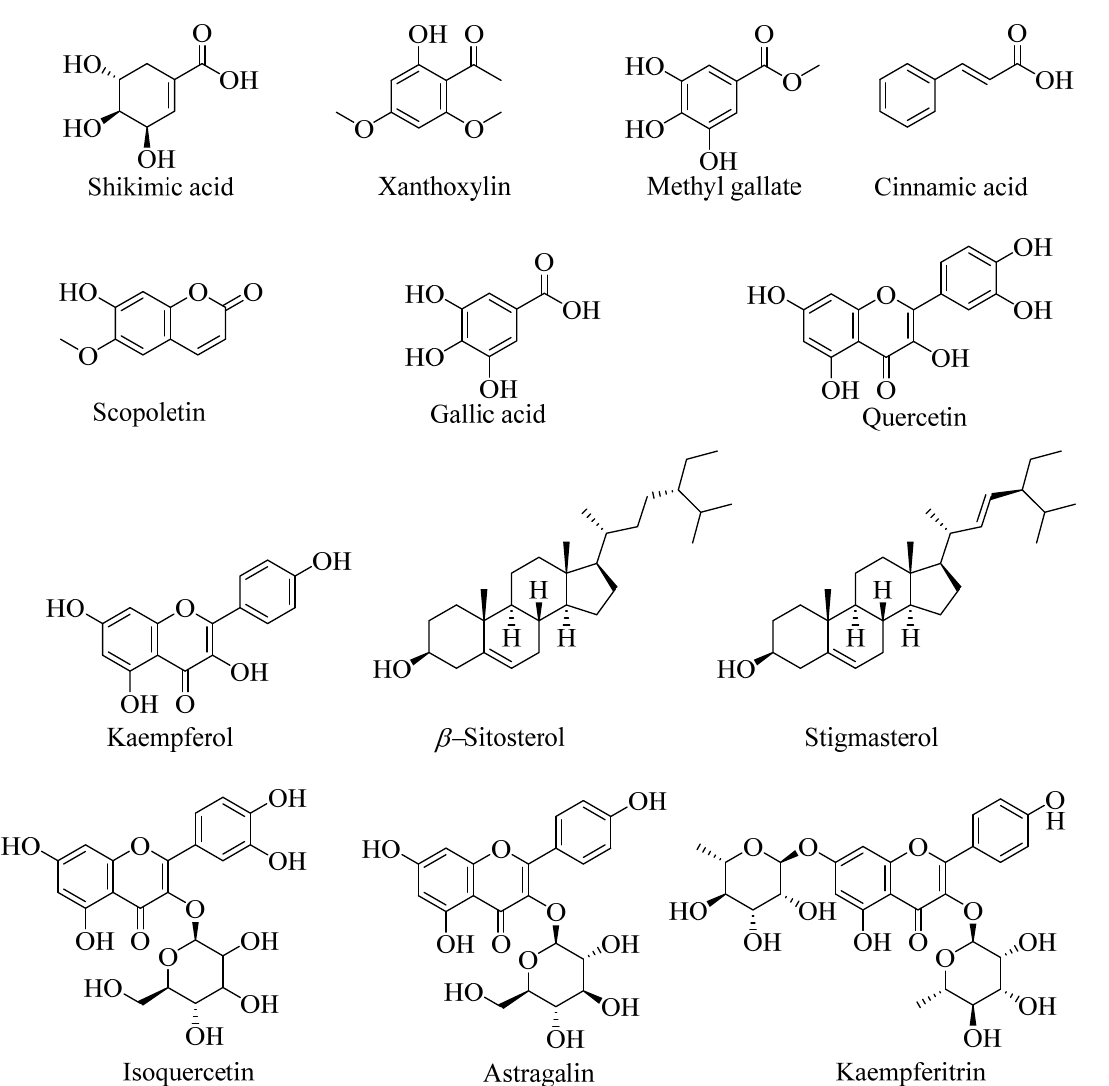
Figure 1. Structures of identified metabolites from leaf and bark ethanol aqueous extracts of Triadica sebifera.